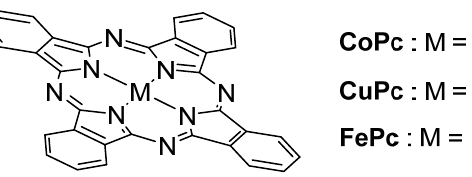
Figure 2. Chemical structures of metallophthalocyanine complexes (MPcs) with different metals.